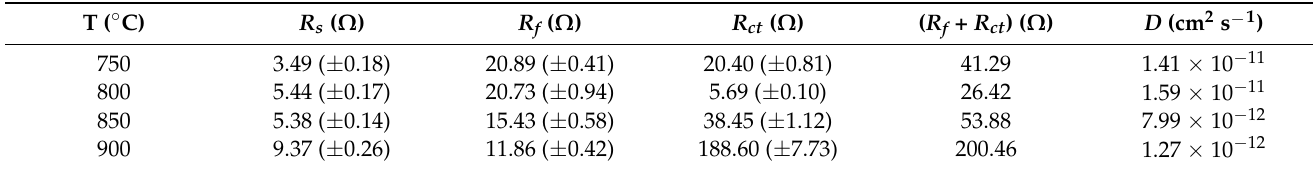
Figure 5. The initial charge-discharge curves ( a ), Nyquist plots ( b ), and Z’ vs. ω − 1/2 plots ( c ) of LiNi 2/3 Co 1/6 Mn 1/6 O 2 prepared at different temperatures. Table 2. Electrochemical impedance spectroscopy (EIS) analysis results of LiNi 2/3 Co 1/6 Mn 1/6 O 2 prepared at different temperatures.